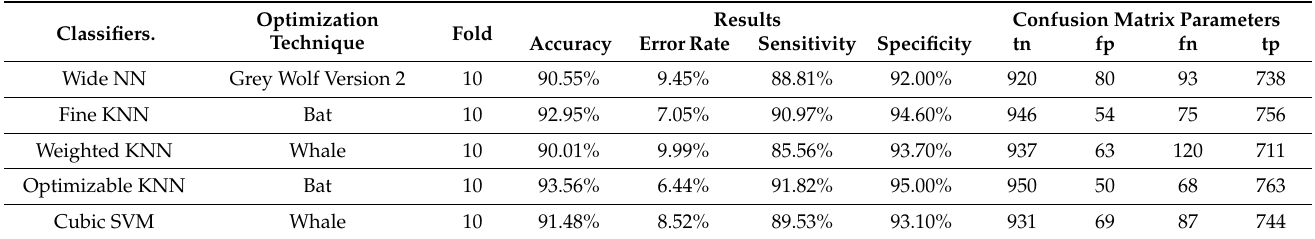
Table 9. Performance of various classifiers using GLRM, statistical features, GLCM, and Hu’s invariant moments.